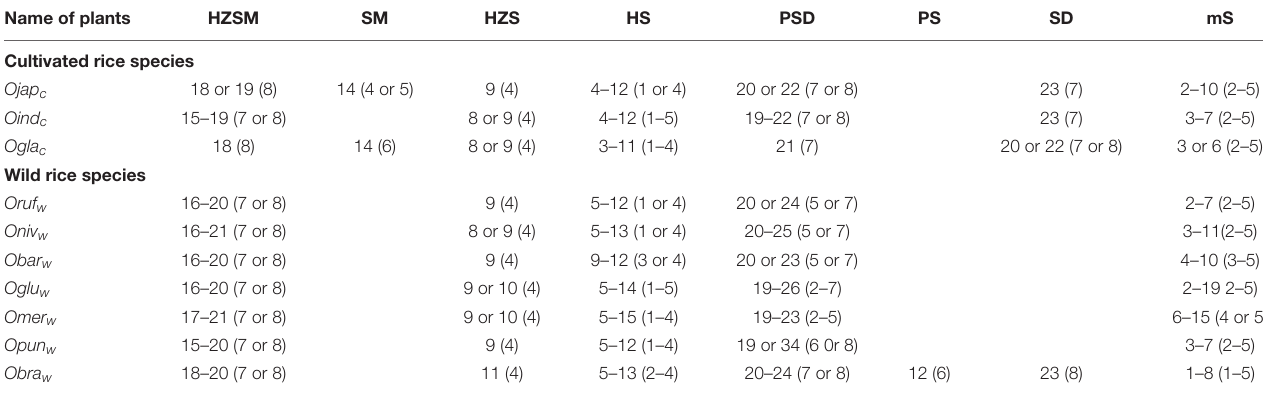
FIGURE 1 | Schematic overview of domain arrangement of START proteins and gene structure of all 28 STARTs genes in Oryza sativa var. japonica. Index shows exonic colors for homeodomain (HD), homeodomain associated basic leucine zipper domain (HD bZIP), START domain, PH domain, domain of unidentified function (DUF1336), and MEKHLA. The exon portions that code the protein inter-domain regions (gray colored regions in domain arrangement) are depicted in mint shades at gene structure. (*Gene pairs are proximally duplicated and shows higher resemblance in gene structure). TABLE 2 | Gene structure analysis: number of exons involve in coding full-length START proteins for different structural classes amongst 10 cultivated and wild Oryza